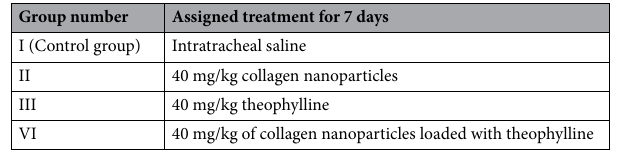
Table 1. Categorisation of treatment